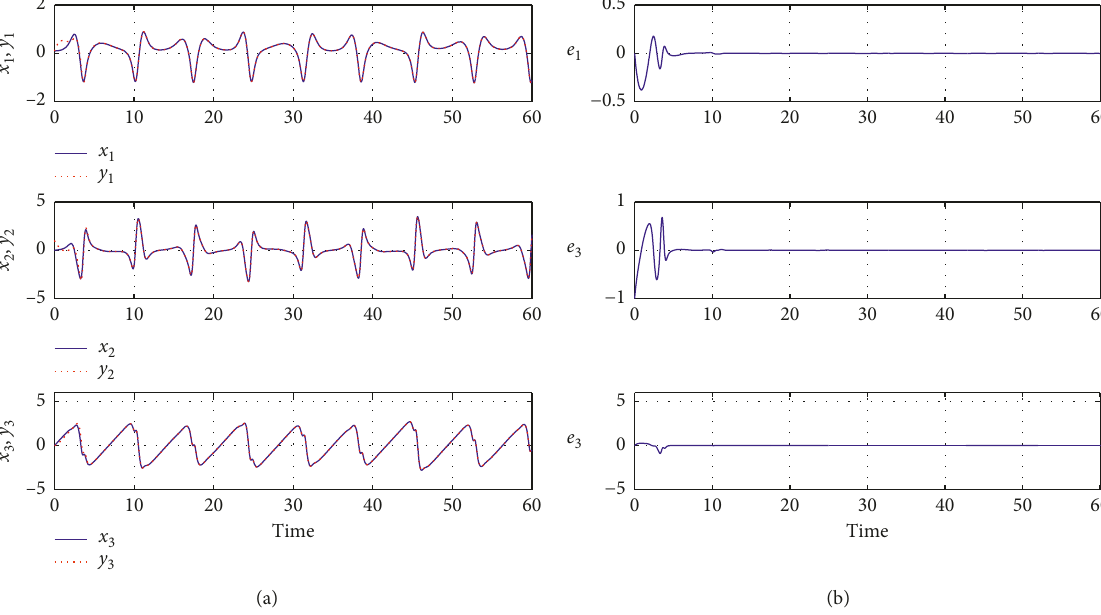
Figure 13: (a) Time response of the states and (b) synchronization error with μ � 2, x ( 0 ) � ( 0 . 1 , 0 , 0 ) and y ( 0 ) � ( 0 . 1 , 1 , 0 )